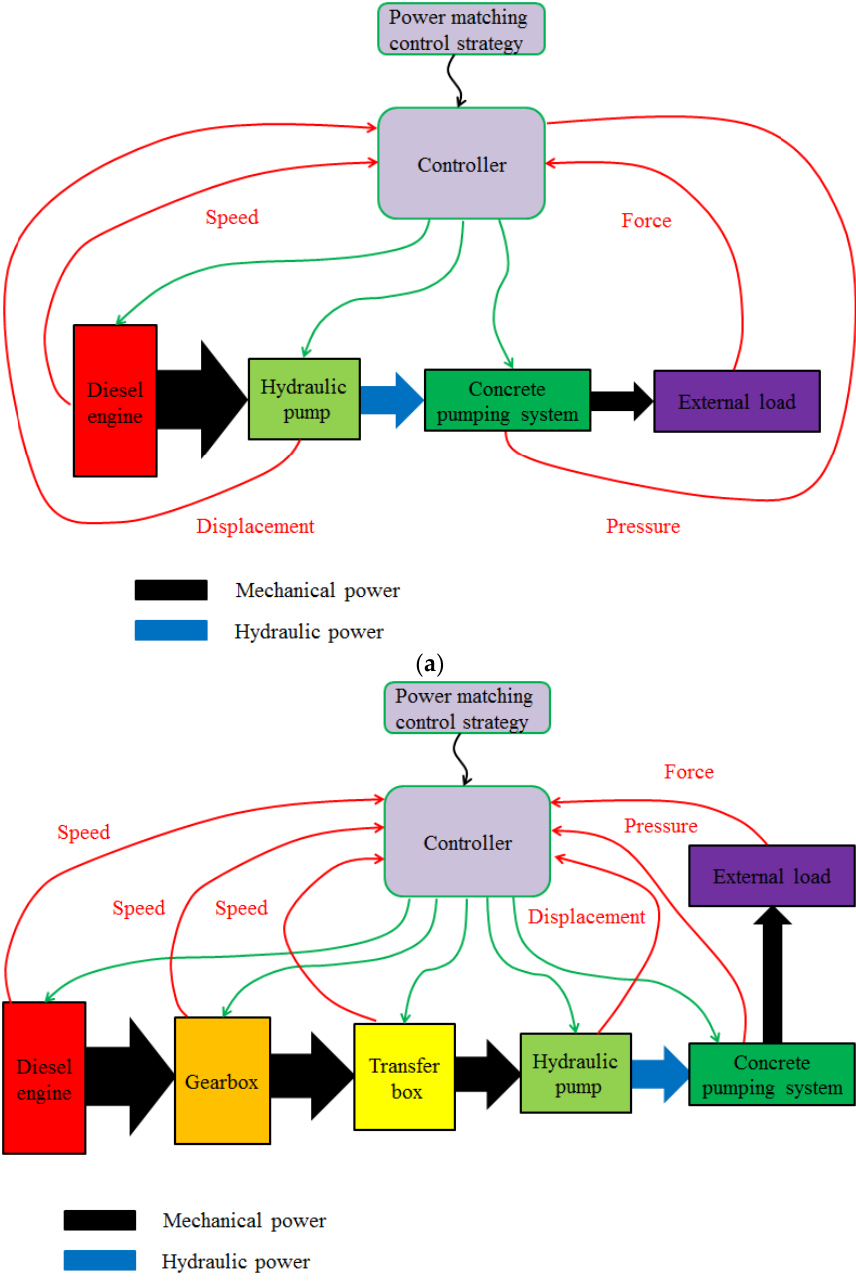
Figure 9. Schematic of power matching approach of energy conservation for concrete pumps. ( a ) Power matching approach of trailer concrete pump. ( b ) Power matching approach of transport- ed/truck-mounted concrete pump.